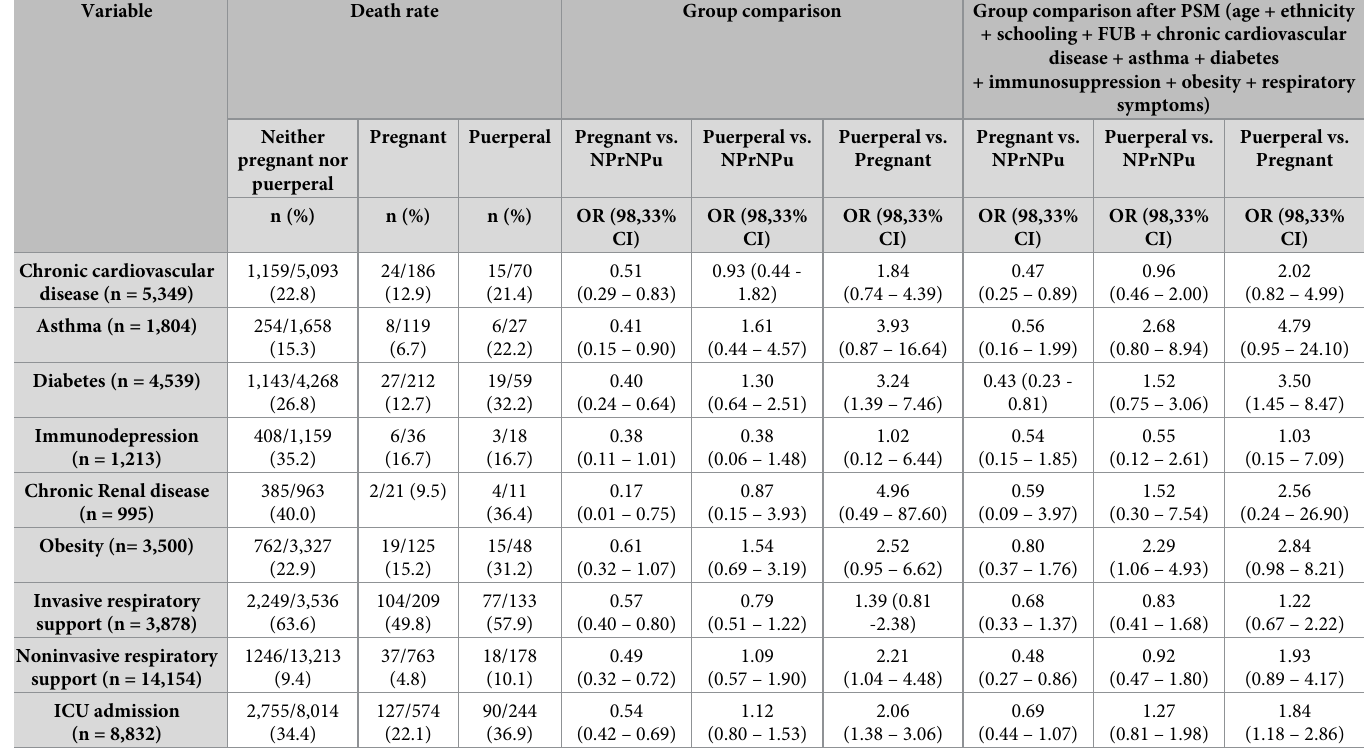
Table 4. Comparison of the death rates of pregnant, puerperal, and neither pregnant nor puerperal reproductive age women before and after propensity score matching according to comorbidities, ICU admission, and ventilatory support – Brazil, February 17, 2020 – January 02, 2021.